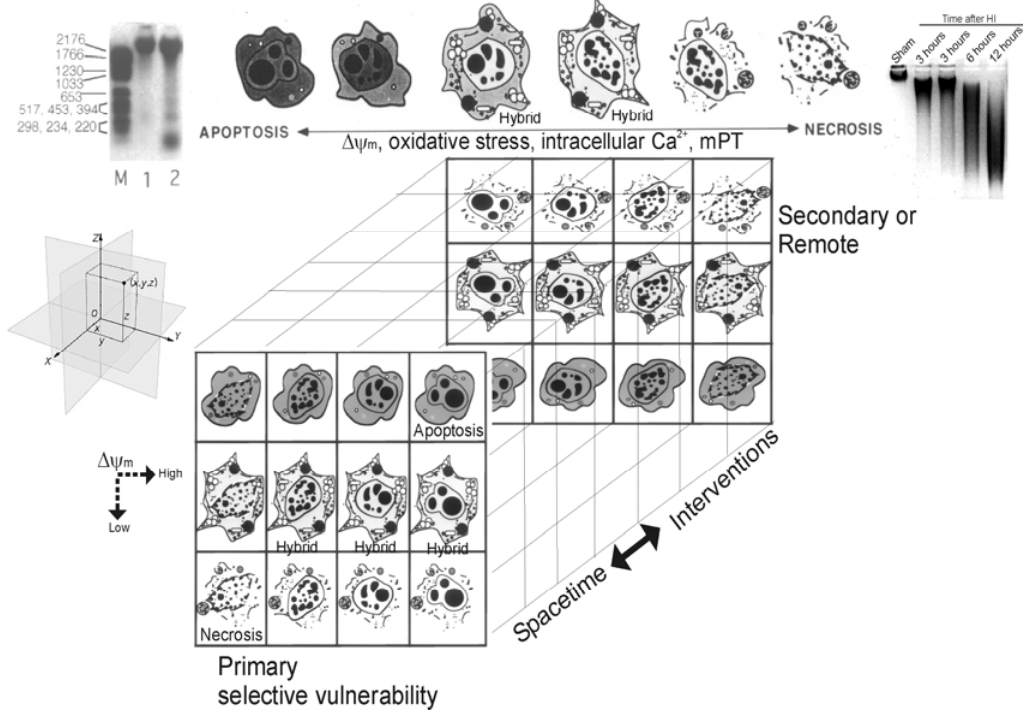
Figure 2. Cell death matrix (modified from its original form [194]). This diagram summarizes in linear (top) and 3-dimensional matrix (bottom) formats the concept of the apoptosis-necrosis continuum of cell death. See text for